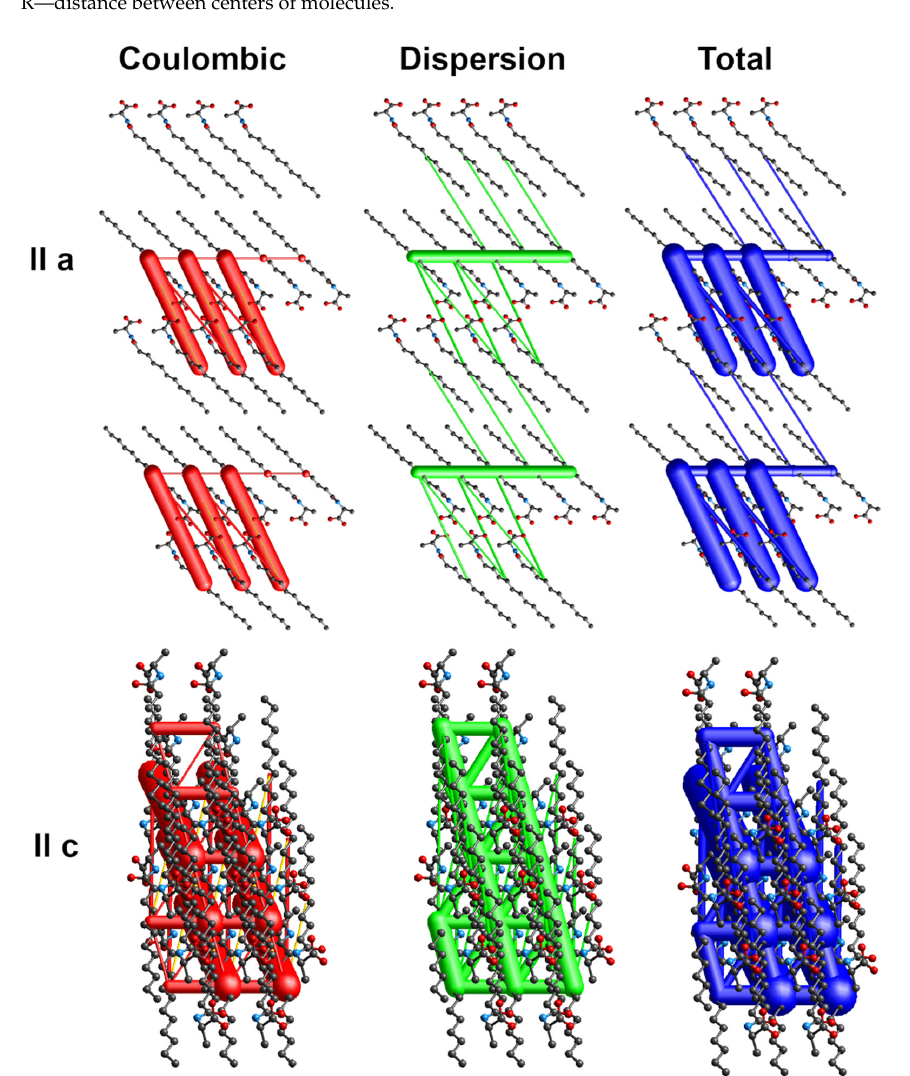
Figure 4. Energy frameworks for 1-Ala. View along a and c directions. Various colors represent various energy terms: red—coulombic, yellow—polarization, green—dispersion, and blue—total energy. The applied scale for tube size 150, the energy cut-off 5 kJ/mol.